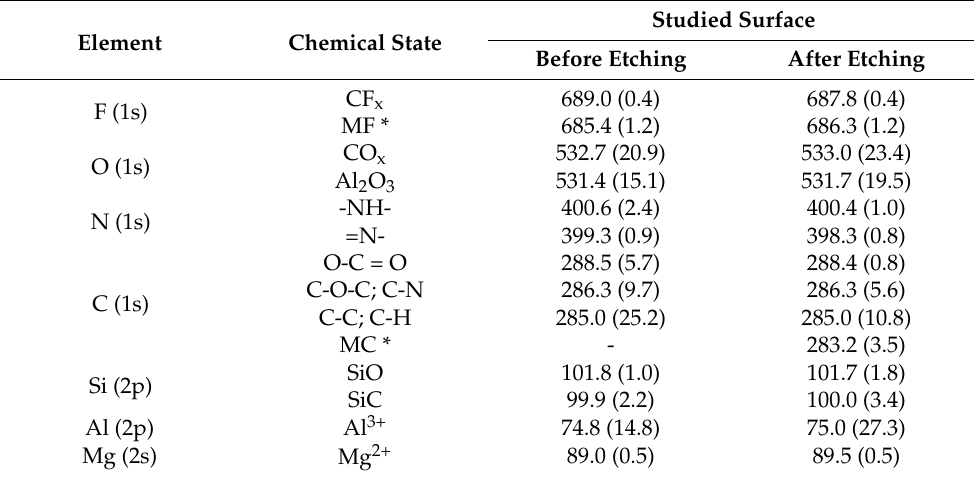
Table 2. Binding energy (eV) and elemental composition (at. % in parentheses) of the surface of CC-btr-24